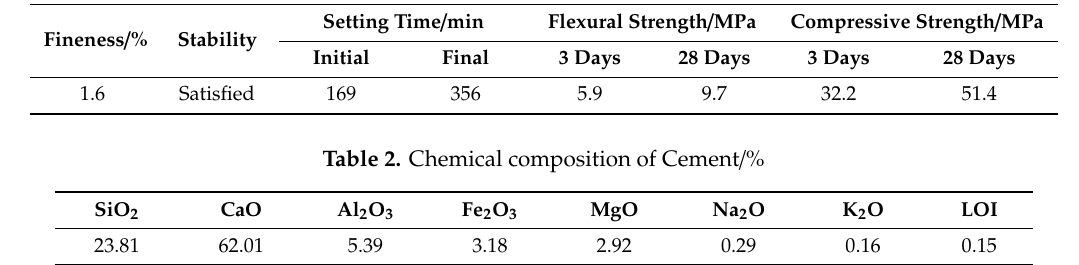
( b ) ( c ) Figure 2. ( a ) Particle distribution of synthesized nano C-S-H particles; ( b ) XRD pattern of the synthesized nano C-S-H particles; ( c ) SEM image of synthesized nano C-S-H particles.